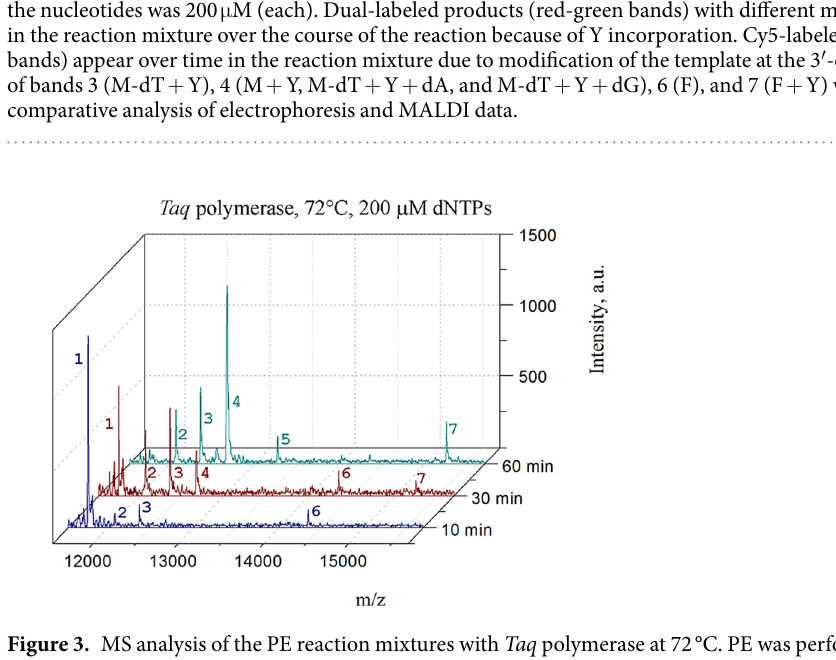
is available from the MALDI mass spectra of the reaction mixtures and is shown in Fig. 3 and Suppl Fig. SF1. Extension with Taq polymerase results in more diverse reaction mixtures. At 72 °C, we observed that the newly synthesized strand F and template (M) undergo further transformations, yielding F + Y, M + dA, M-dT + Y, M + Y, M-dT + Y + dA, and M-dT + Y + dG strands (Tables 1 and ST1). The latter three products, largely M-dT + Y + dA, constitute peak 4 as their masses fall in the narrow 25-Da range. Typically, the M and F strands were largely depleted after 2 hours of exposure. Additionally, the M-dT + Y + Y strand was generated. Decreasing the temperature to 64 °C or lowering the dNTP concentration slows down the terminal transformations, although it yields the same pool of products. The role of temperature in the rate and extent of terminal modifications is likely related to the enzyme working optimum rather than the thermal stability of DNA duplex. The Taq DNA polymerase has an optimal temperature approximately 72 °C, which is typically higher than the T m value of the primer/template duplex in most applications. In the present PE model, the T m value of the full-length duplex M:F in the reaction buffer is 68 °C. Therefore, partial duplex unwinding at sequence ends is expected at either tem- perature (72 or 64 °C). In the PE reaction with Vent (exo-) polymerase, only two major modification products were observed at 72 °C: F + Y and M-dT + Y. At a lower temperature, an additional strand, F + dA, was observed.